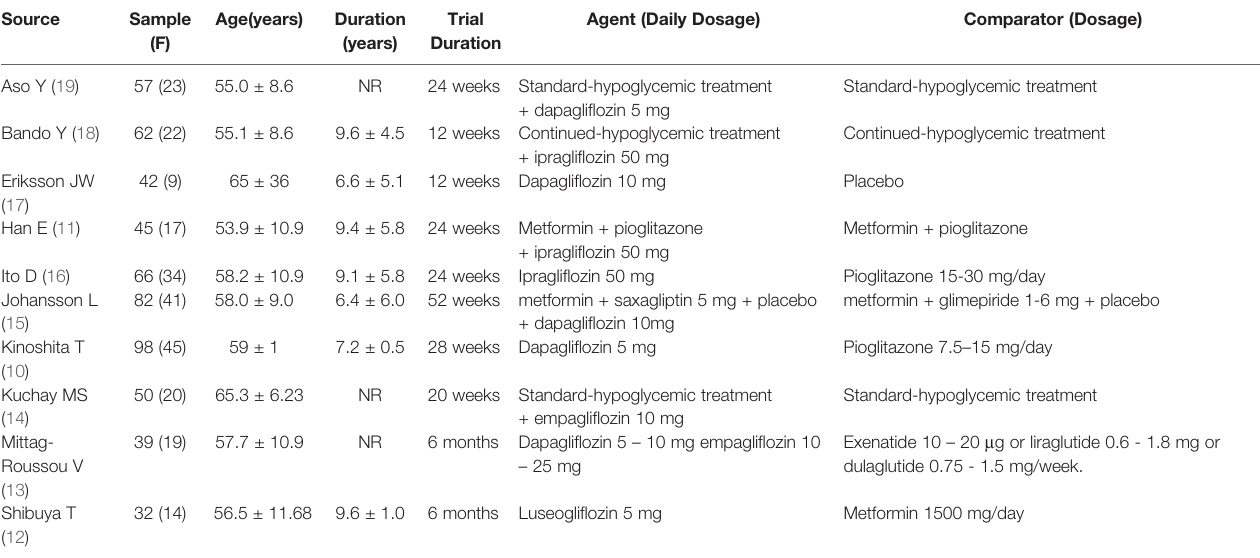
TABLE 1 | Demographic and clinical characteristics of included